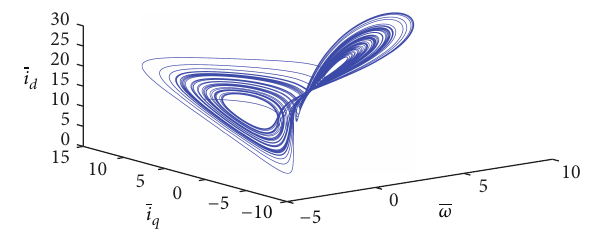
Figure 2: The strange attractor of the chaotic